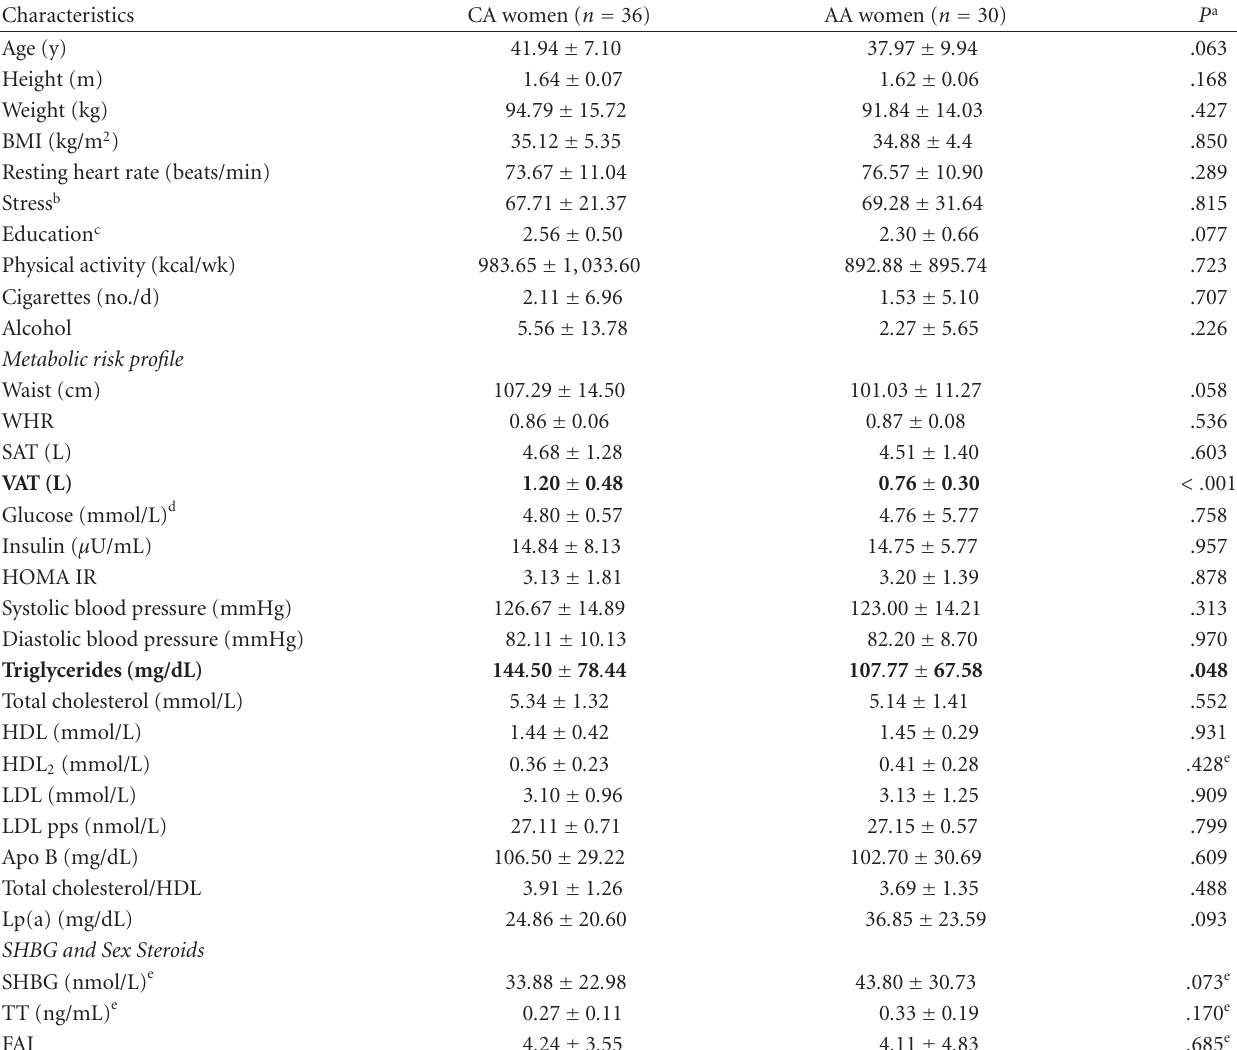
Table 1: Comparison of subject characteristics between CA and AA women using student’s t -tests for unpaired samples.